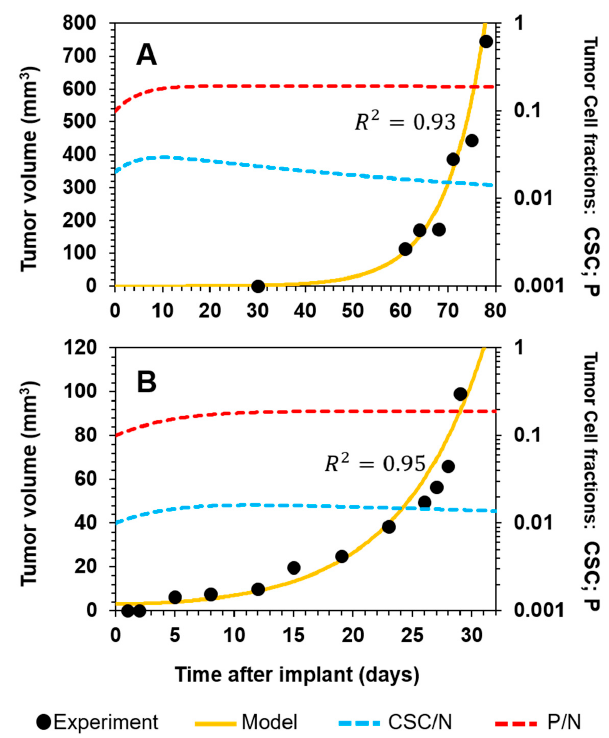
Figure 2. Model fitted to control experiment scenarios. ( A ) Human-derived breast cancer cells (3 × 10 4 ) were implanted in the mammary fat pads of mice [14]. ( B ) Human breast cancer cells (1 × 10 6 ) were implanted in the inguinal mammary glands of mice [13]. Experimental data are represented by black points, model fitting by the yellow line, the CSC fraction by the dashed blue line, and the P fraction by the dashed red line.